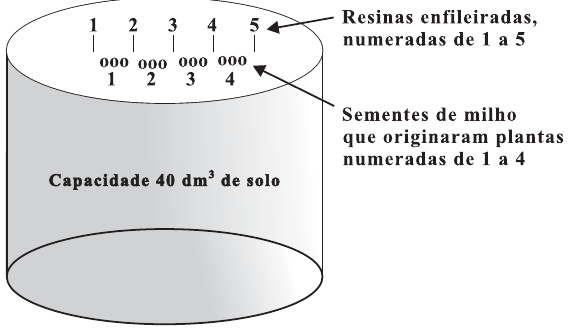
Figura 1. Disposição das resinas enterradas e das sementes de milho em vasos com capacidade de 40 dm 3 e raio de aproximadamente 150